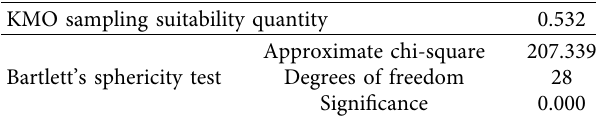
Table 15: KMO and Bartlett’s tests.